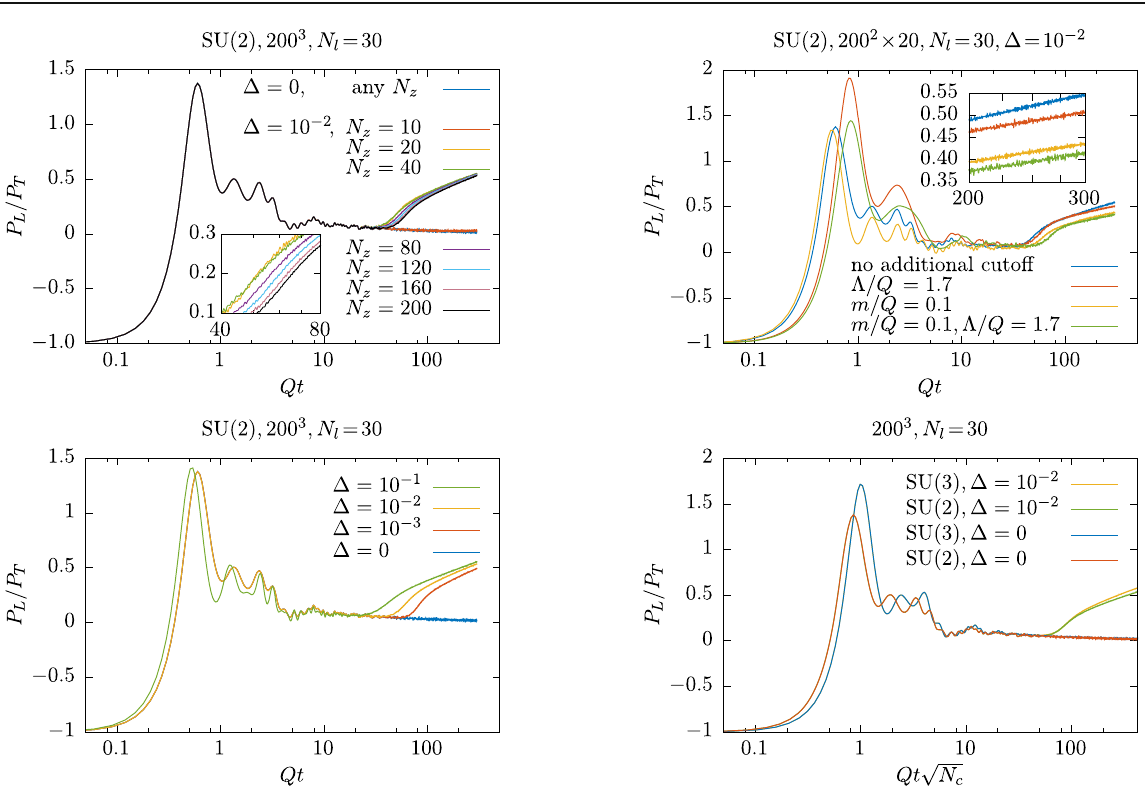
Fig. 9 Pressure ratio in the static box for different IR and UV cutoffs (top) and for the different gauge groups (bottom) Table 2 Hydrodynamisation time extrapolations in units of Q − 1 for different lattice and CGC parameter